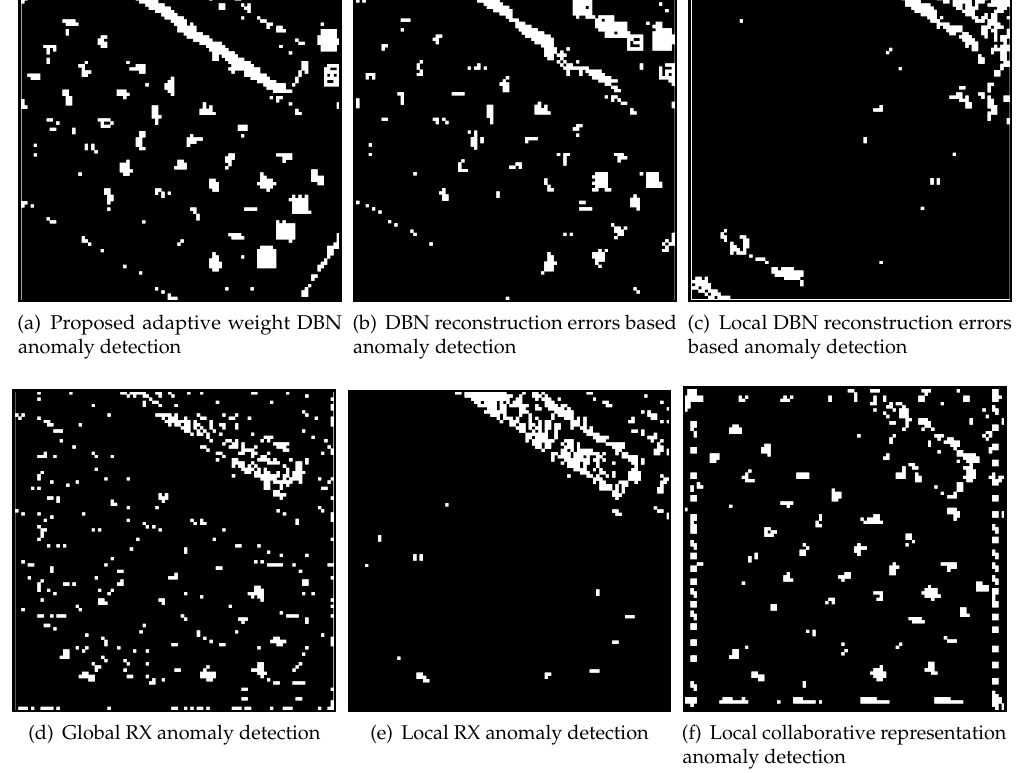
Figure 14. The targets detection results image of San Diego airport HSI image. Fixed false positive rate for all images in Figure 14 is 0.05.